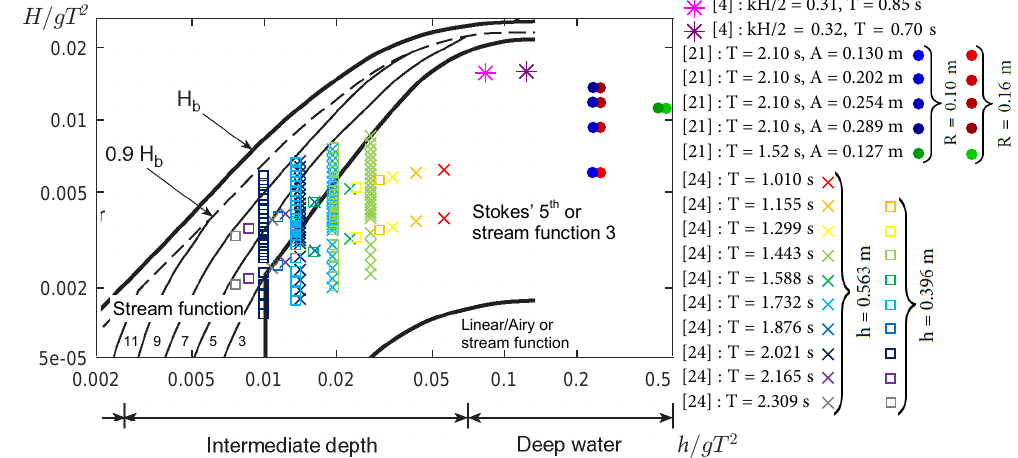
Figure 3. Experimental studies analyzed in this paper with reference to the limitations of regular wave theories as defined by IEC 61400-3 Design requirements for offshore wind turbines [34]. H b denotes the wave height corresponding to the wave-breaking limit. Identical markers in the Kristiansen and Faltinsen (2017) [24] cases refer to cases with increasing steepness for the same wave period and water